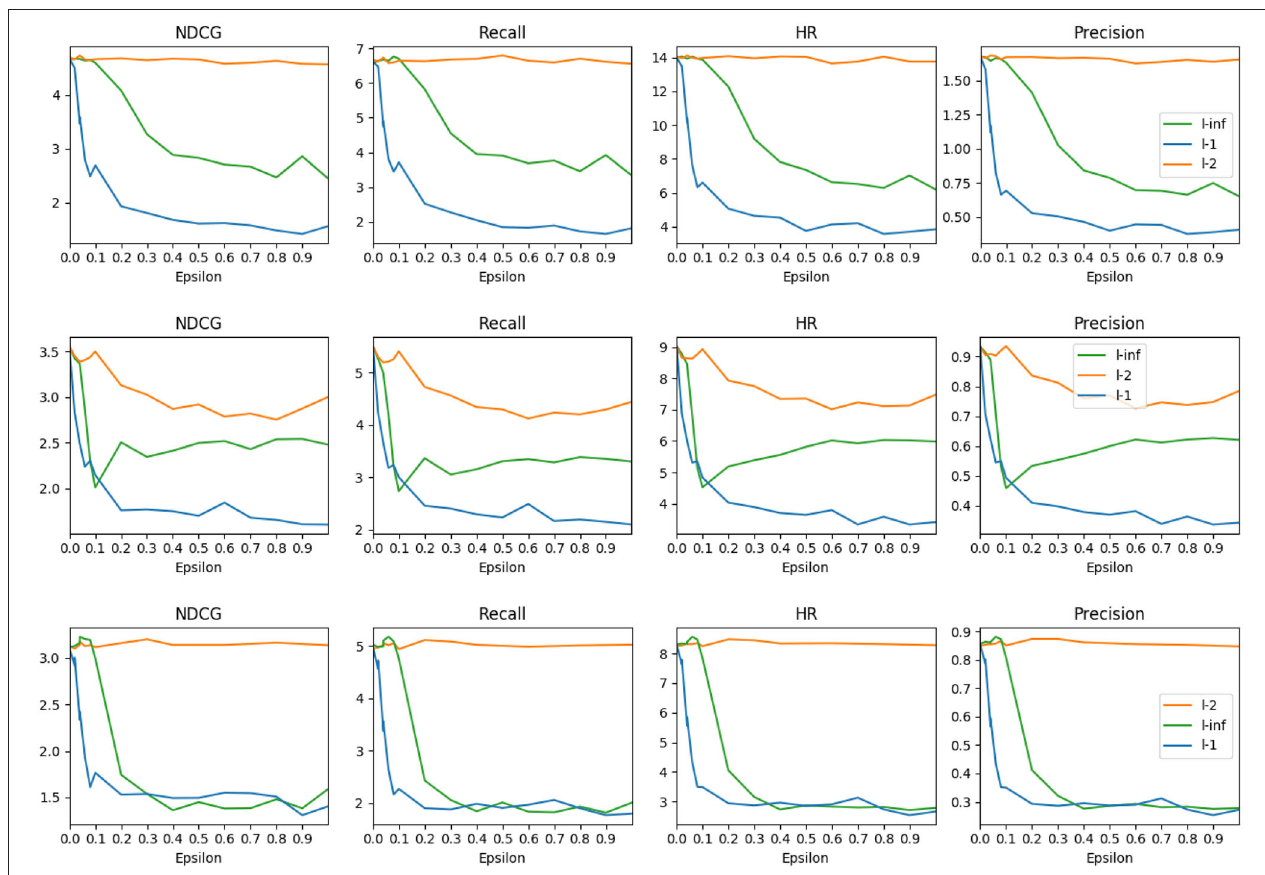
FIGURE 2 | Comparison of three attack methods, l , l 2 , and l 1 on three datasets (from top to bottom): Amazon Beauty, Amazon Cellphones, and Amazon Clothing. ∞